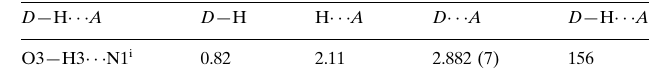
Hydrogen-bond geometry (A˚ , (cid:2)